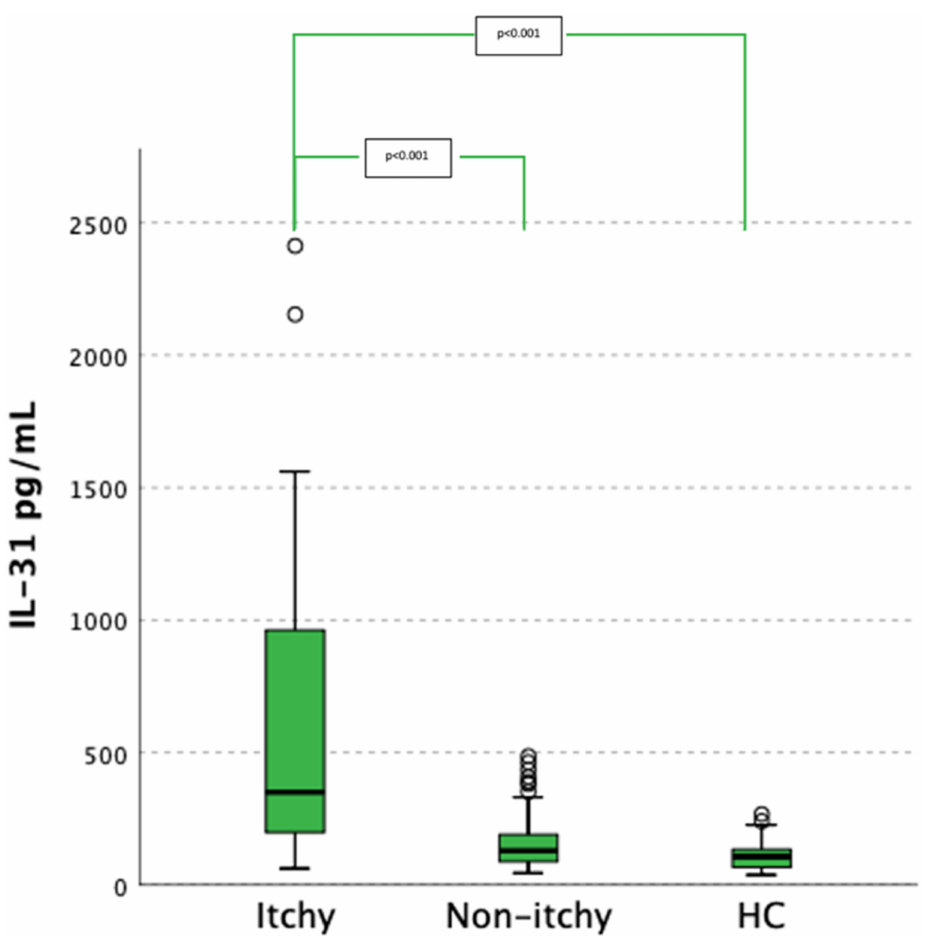
Figure 1. Kruskal–Wallis test and posthoc analysis of the differences in serum IL-31 concentrations between studied groups. HC—healthy